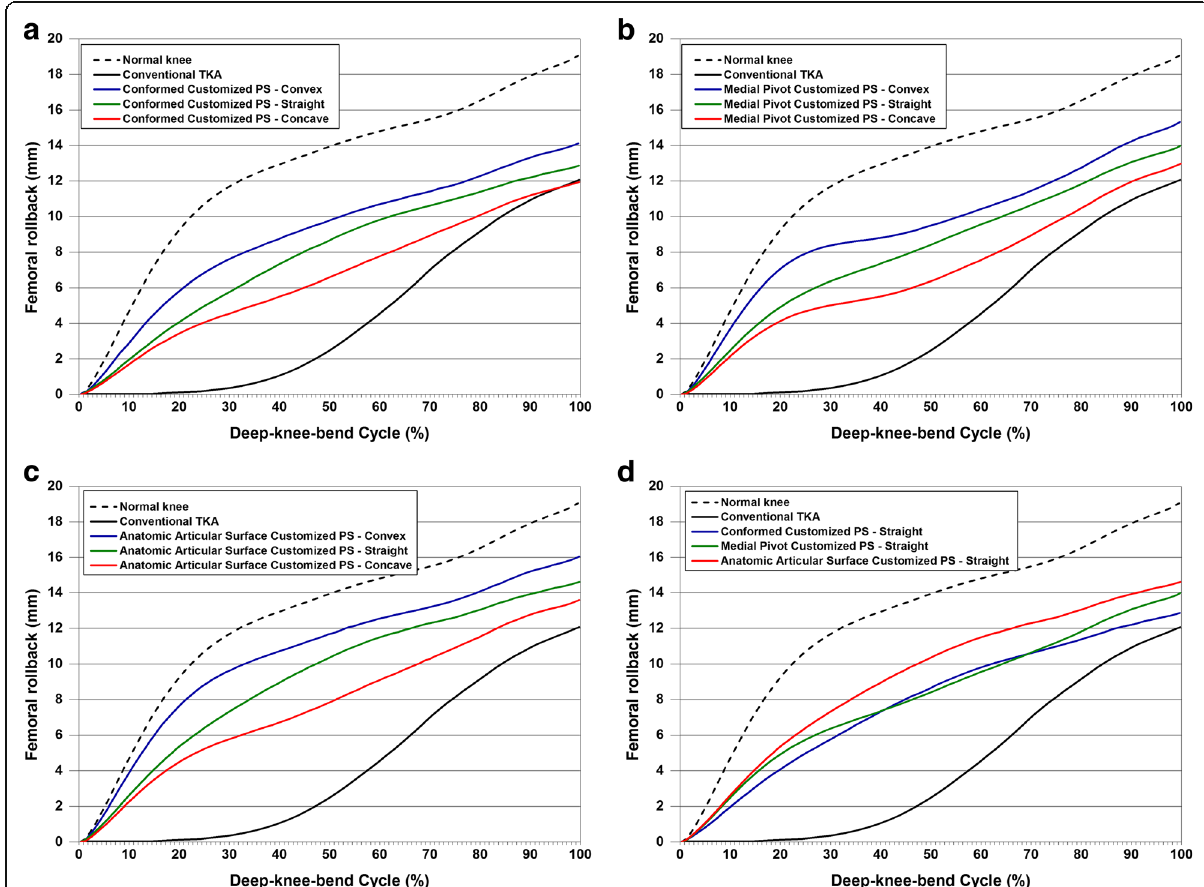
Fig. 6 Comparison of femoral rollback in ( a ) Conformed Customized PS-TKA, ( b ) Medial Pivot Customized PS-TKA, and ( c ) Anatomic Articular Surface Customized PS-TKA with regard to different cam designs in the tibial component and ( d ) straight post designed tibial component with regard to different conformity designs in the tibial component under